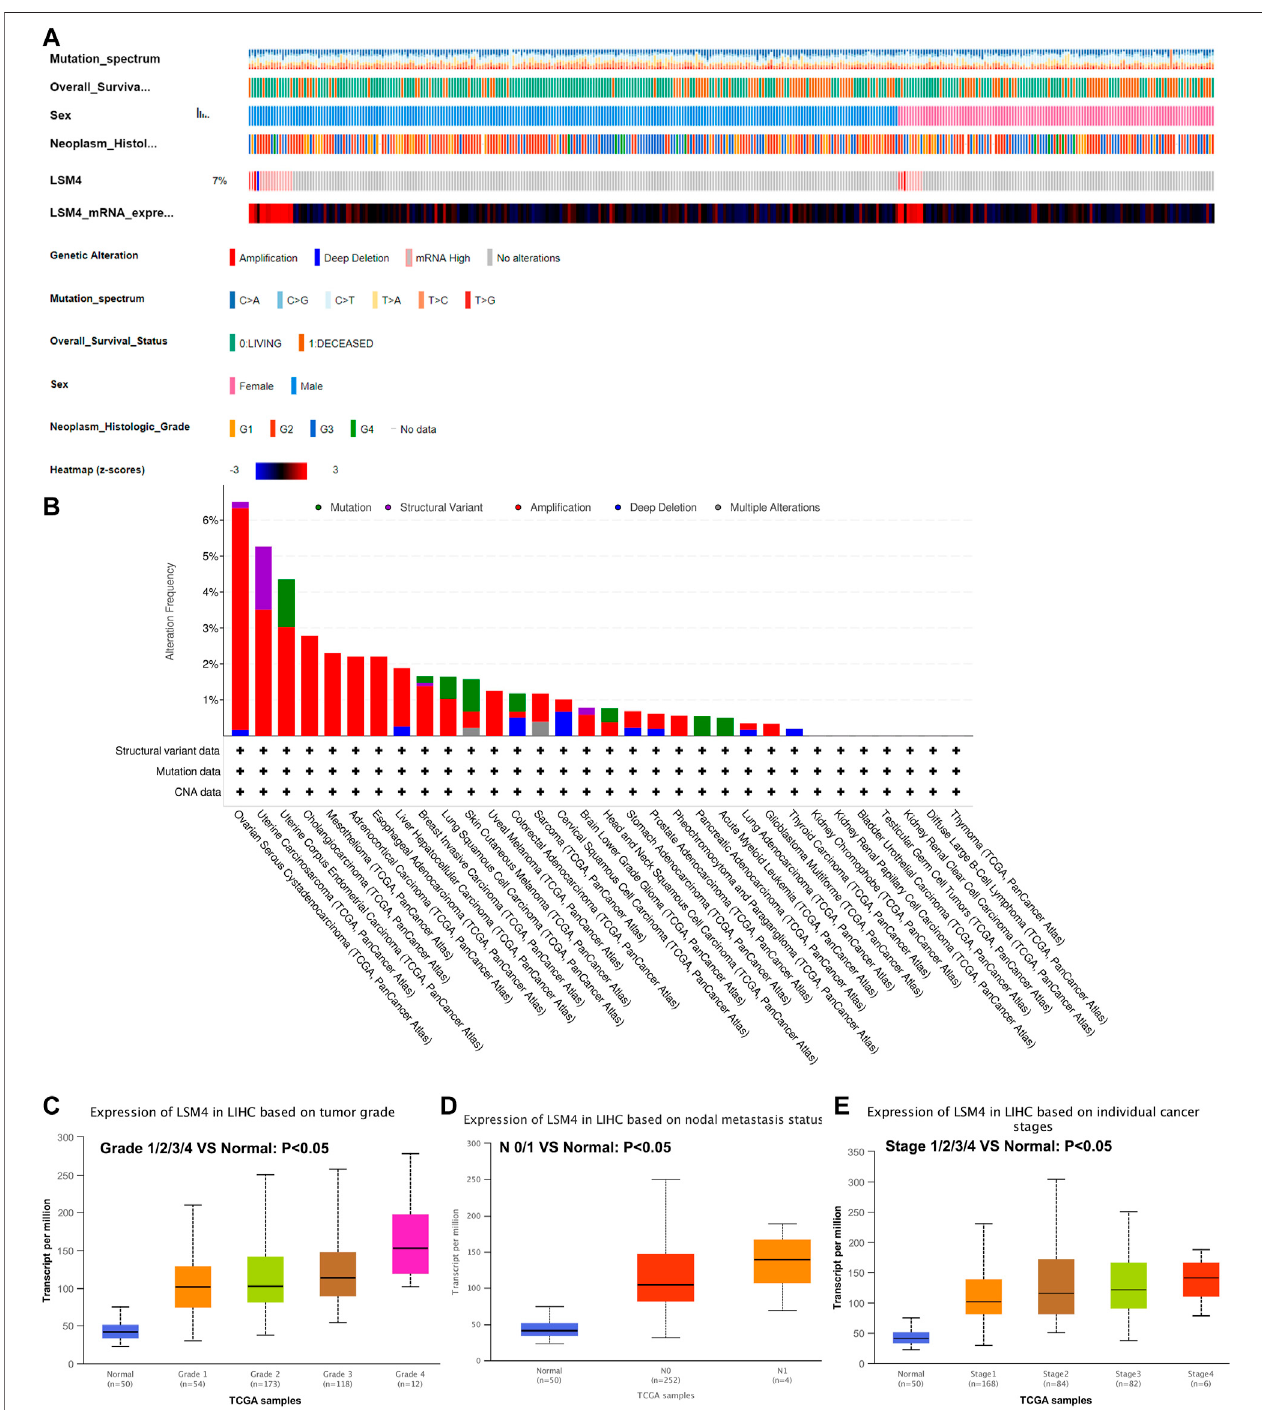
FIGURE 3 | LSM4 genetic alteration status based on cBioPortal and the relationship between LSM4 expression and clinical characteristics of hepatocellular carcinoma based on UALCAN databases. LSM4 was altered in 26 (7%) of the queried 372 hepatocellular carcinoma patients (A – B) . The expression of LSM4 in hepatocellular carcinoma based on tumor grade, and node metastasis status, and individual cancer stages (C – E) .